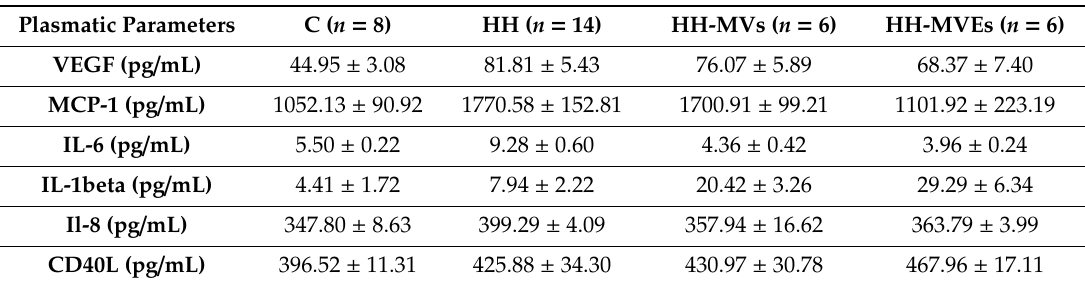
Table 6. Analysis of plasma cytokine and chemokine profiles, inflammatory biomarkers with a role in the pathogenesis of vascular complications, by the ELISA method for all experimental groups (C, HH, HH-MVs, HH-MVEs).